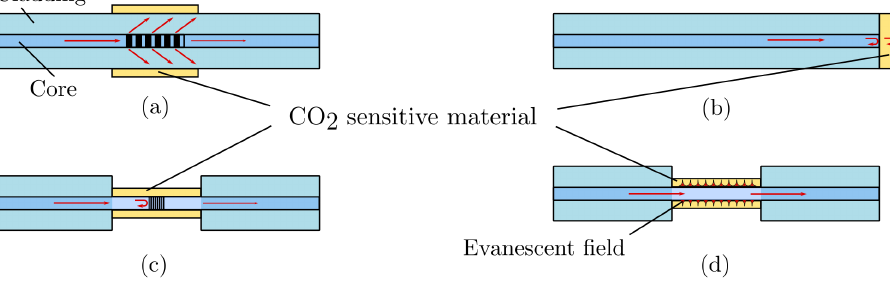
Figure 8. “Various techniques that have been employed in CO 2 sensors to cause light propagating in the core to interact with the surrounding environment: ( a ) [Long Period Grating]; ( b ) extrinsic Fabry- Perot cavity; ( c ) [Fiber Bragg Grating] and; ( d ) etched cladding. All the examples here use a material which demonstrates CO 2 sensitivity and the subsequent change in coating upon exposure to CO 2 is sensed by the interacting light”—Text and figure reproduced with permission from Barrington